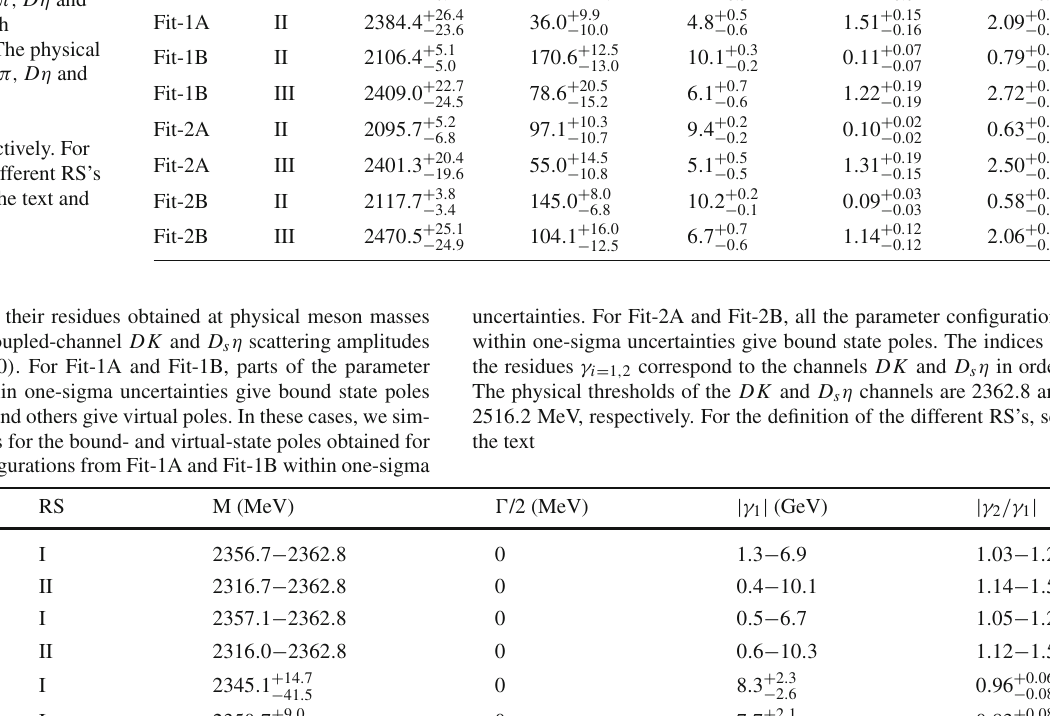
residues obtained at physical meson masses from the S -wave coupled-channel D π, D η and D s ¯ K scattering with ( S , I ) = ( 0 , 1 / 2 ) . The physical thresholds of the D π, D η and D s ¯ K channels are 2005 . 3 , 2415 . 1 and 2463 . 9 MeV, respectively. For